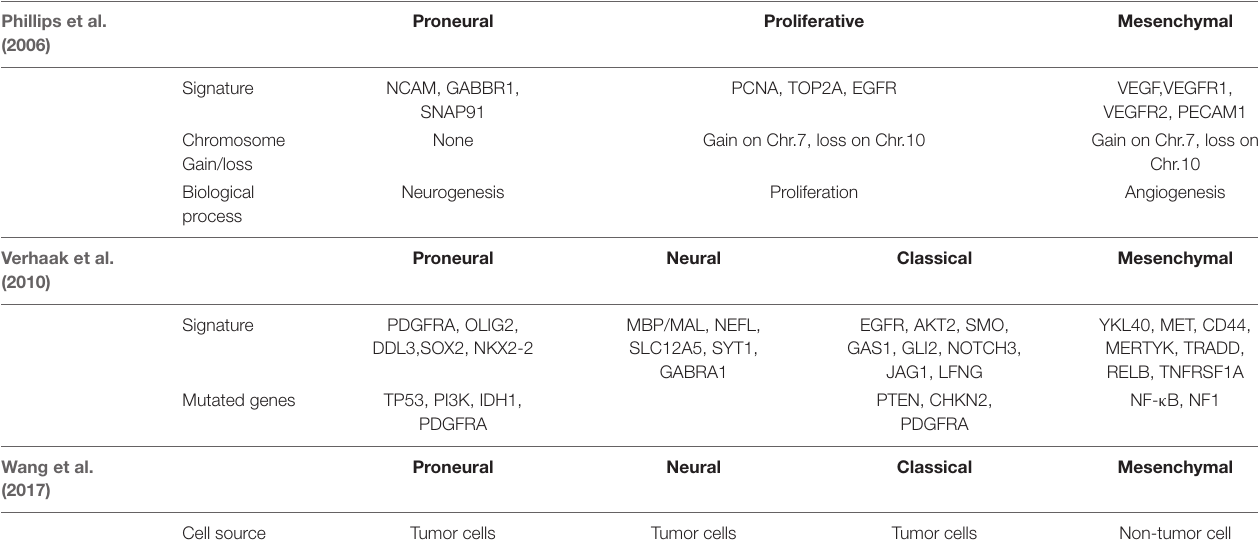
TABLE 1 | The classification by Phillips, Verhaak and